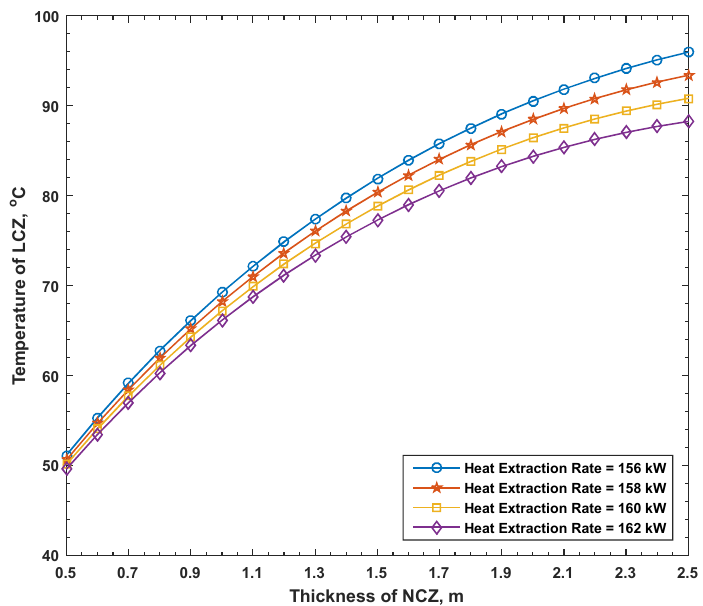
Figure 4. Effect of NCZ thickness and heat extraction rate on the LCZ temperature.